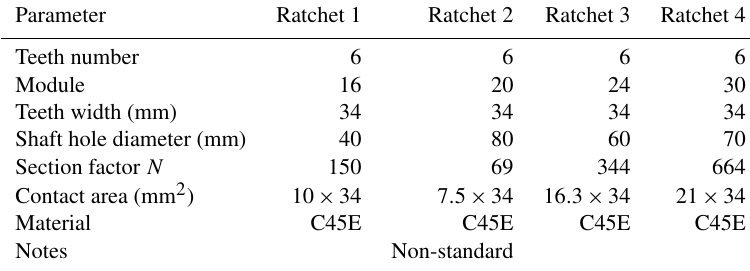
Table 1. The data of four ratchets for the FEA.